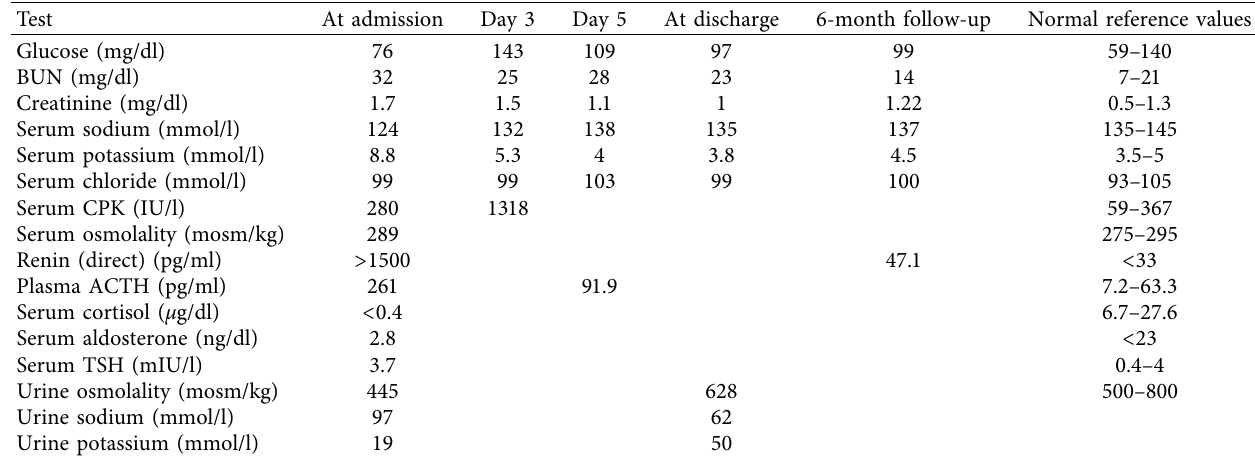
Table 1: Laboratory